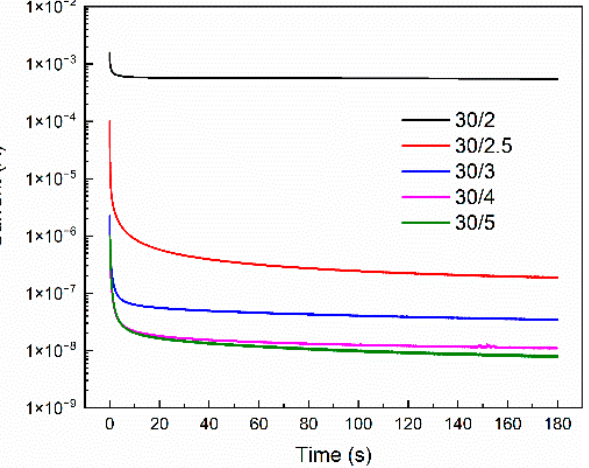
Figure 7. Current–time curves of TaO x films sputtered with various Ar/O 2 ratio under a DC voltage of 2 V.